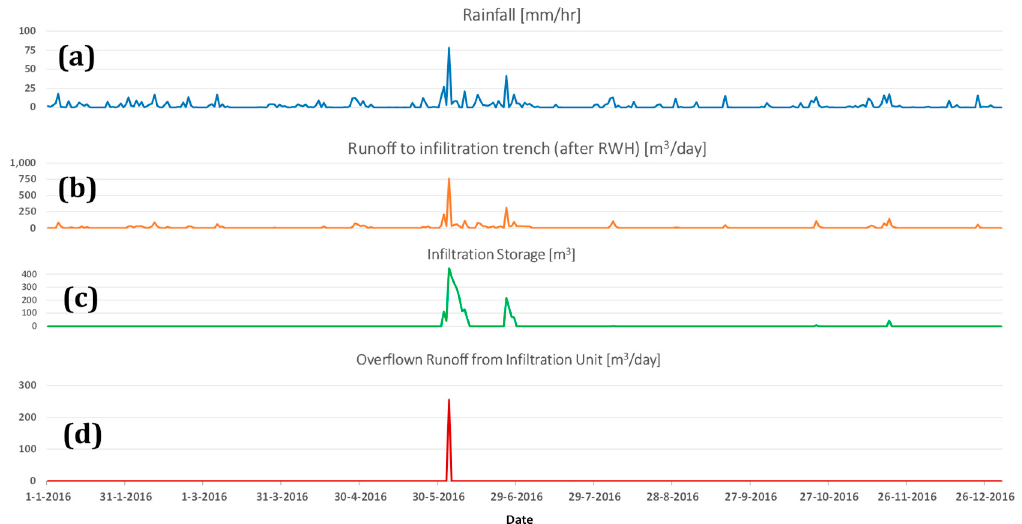
Figure 8. Response of the infiltration unit of SCEN_A during simulation.